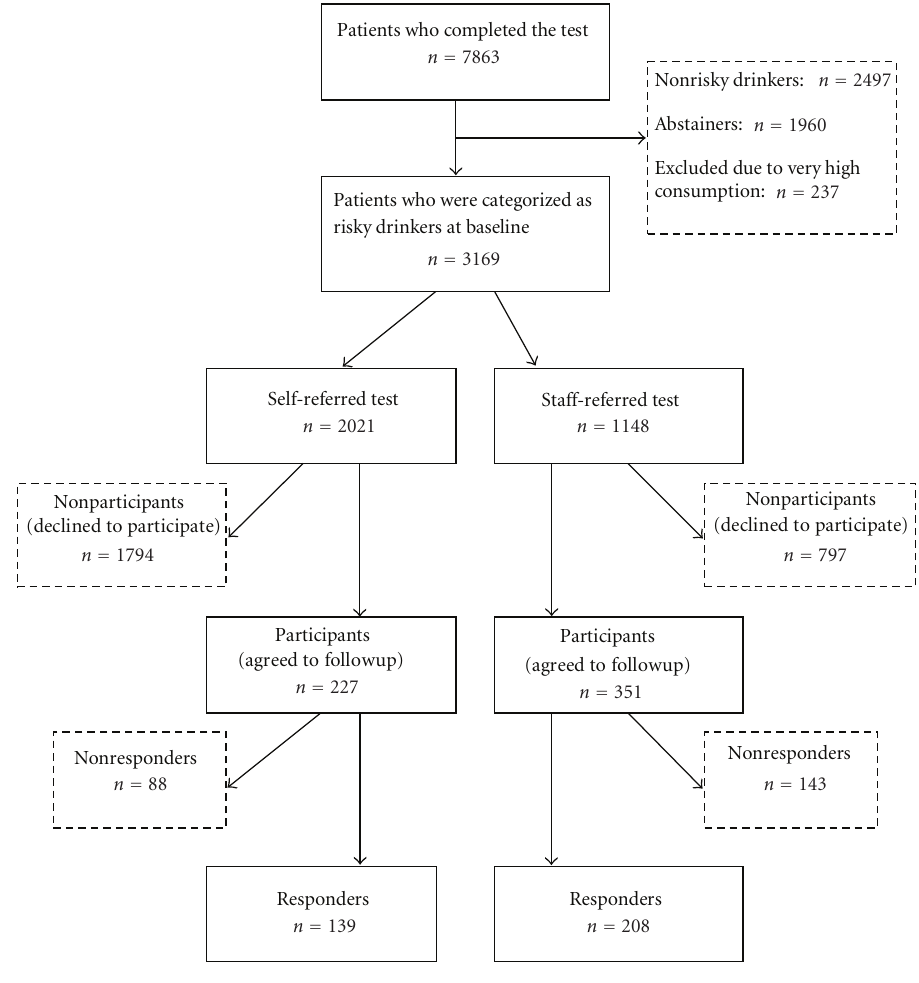
Figure 1: Flowchart of the recruitment of patients as part of the health care